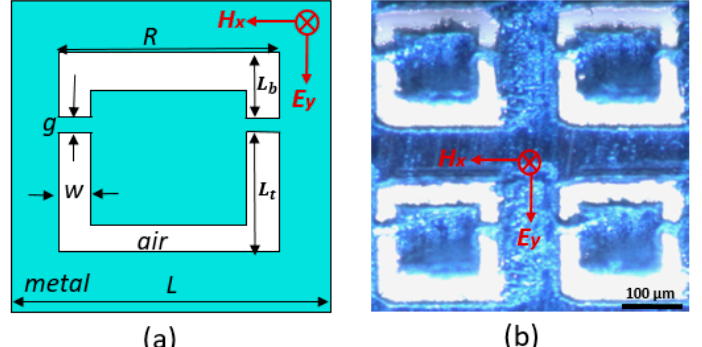
Figure 1. ( a ) Layout of the unit cell of the FCA-SRR with the geometric dimensions L = 300 µ m, w = 25 µ m, R = 200 µ m, g = 15 µ m. ( b ) Microscopic image of four unit cells of the fabricated structure.